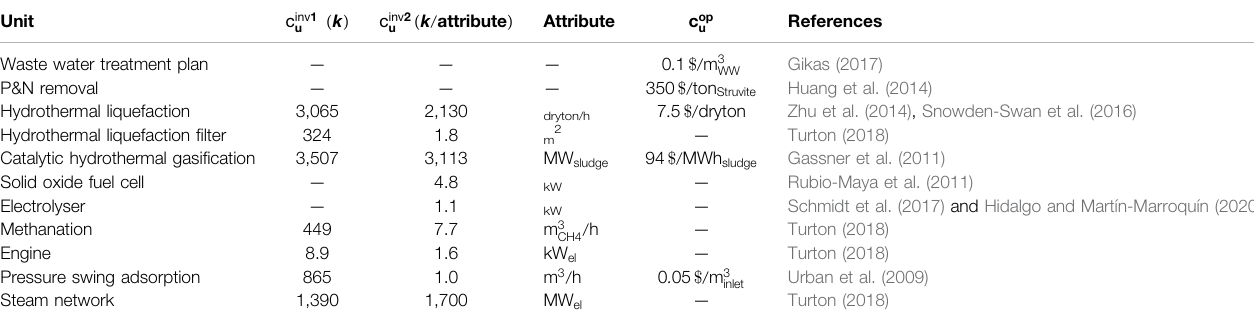
TABLE 1 | Investment and operating costs for current and potential technologies. Unit c inv 1 u ( k ) c inv 2 u ( k / attribute ) Attribute c op